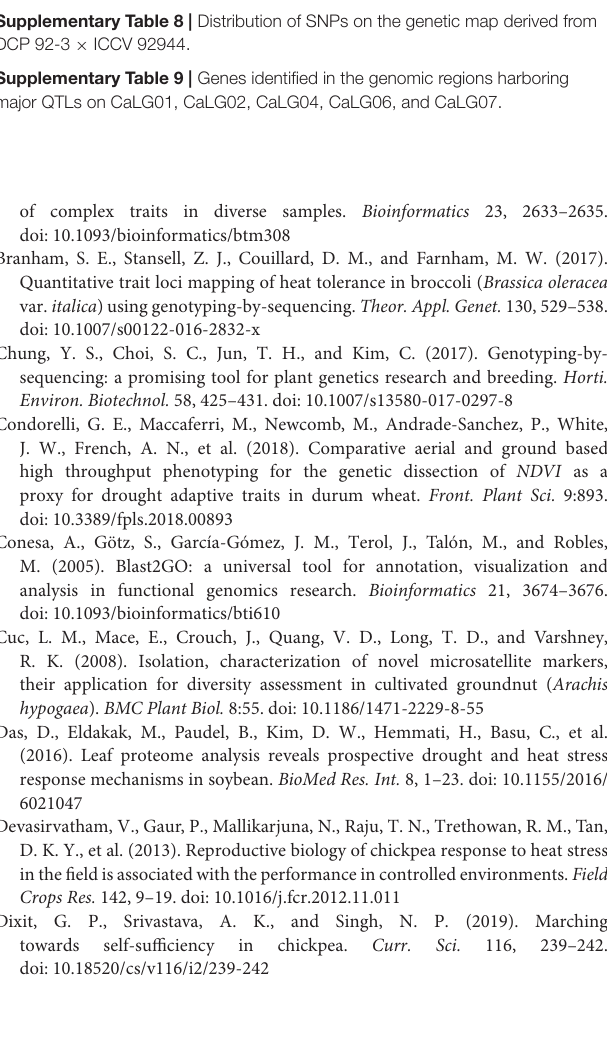
pod filling were recorded, which is more than the critical temperatures that hamper the production of chickpea. Supplementary Figure 2 | High density genetic map comprising 788 single-nucleotide polymorphism markers mapped on eight chromosomes of chickpea. The map distance is indicated as a common scale for all eight linkage groups (CaLG01–CaLG08) on the left side figure and marker names on the right side of each linkage group. Supplementary Table 1 | Correlations among different traits under normal sown environments of 2017–2018. Supplementary Table 2 | Correlations among different traits under late sown or heat stress environments of 2017–2018. Supplementary Table 3 | Correlations among different traits under normal sown environments of 2018–2019. Supplementary Table 4 | Correlations among different traits under late sown or heat stress environments of 2018–2019. Supplementary Table 5 | Correlations between different traits based on pooled data of 2 years under normal sown environments. Supplementary Table 6 | Correlations between different traits based on pooled data of 2 years under late sown or heat stress environments. Supplementary Table 7 | Genotyping-by-sequencing–single-nucleotide polymorphism (GBS–SNP) marker data used for construction of genetic map